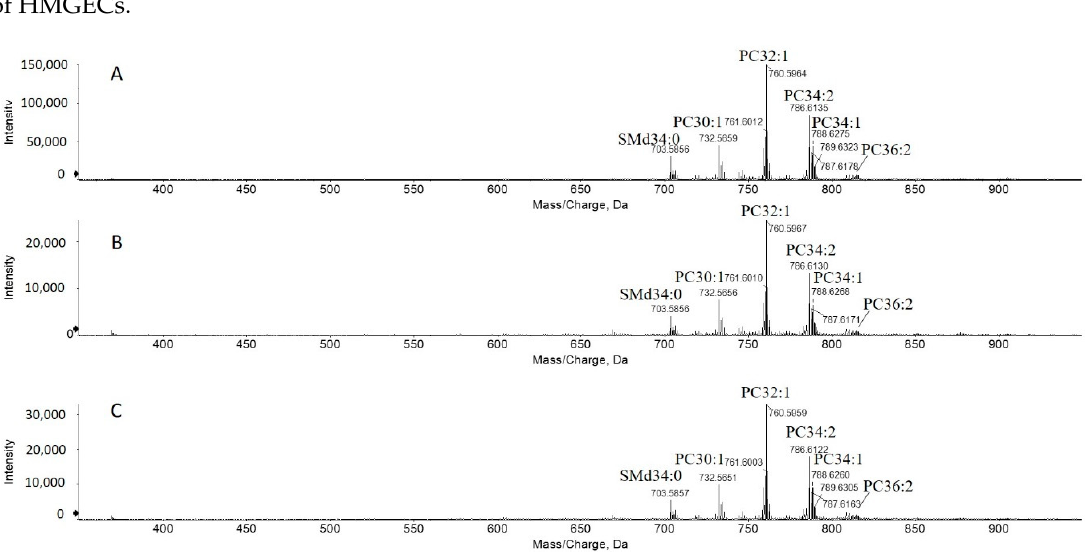
Figure 1. Representative mass spectra of lipids from human meibomian gland epithelial cells (HMGECs) acquired in positive ion mode. HMGECs were harvested by ( A ) 2:1 chloroform–methanol, ( B ) 10 mM ethylenediaminetetraacetic acid (EDTA), and ( C ) 0.25% trypsin–EDTA. Major peaks are identified. Labeling convention is carbon number in the acyl chains: double bond. Sphingomyelin with dihydroxy base (SMd), Phosphatidylcholine